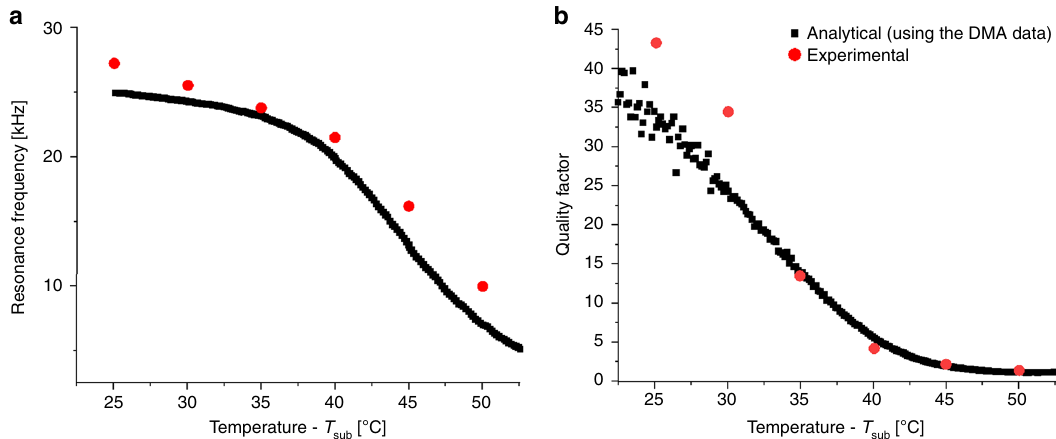
Fig. 2 SMP resonator characterization. a Resonance frequency and b Q-factor of the SMP resonator vs. temperature. Both plots show measured data in vacuum and the analytical solution based on DMA